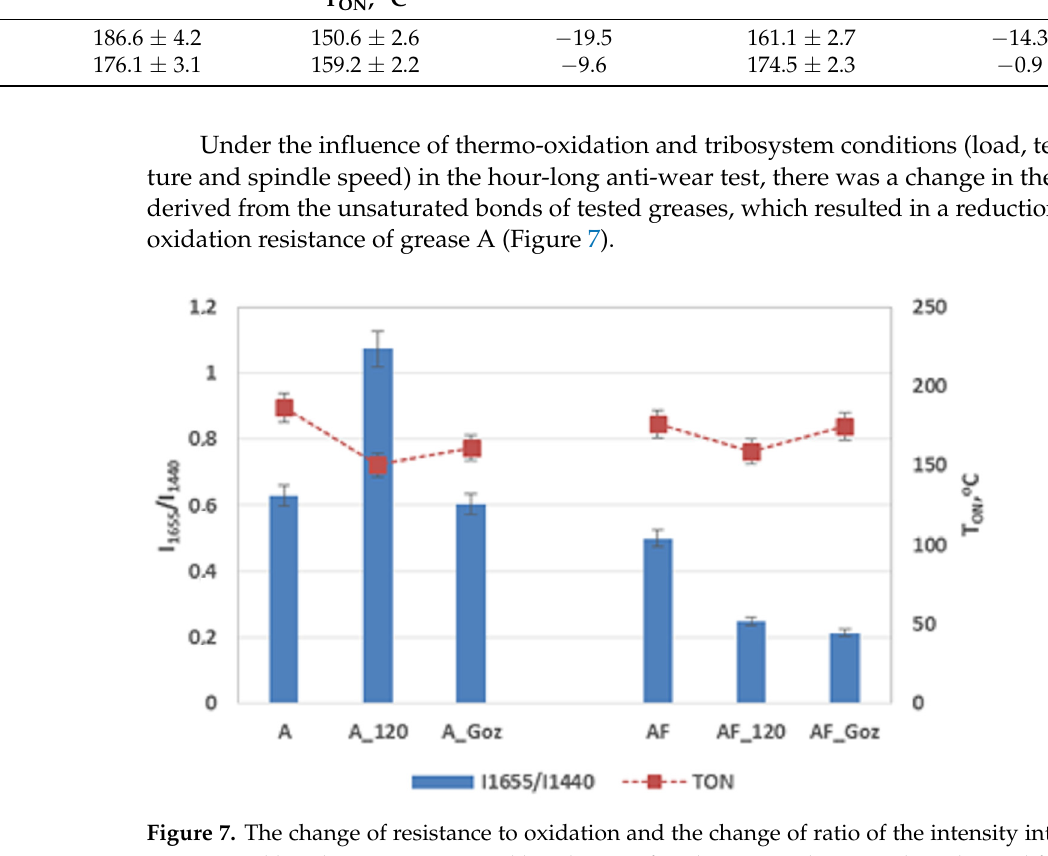
Table 3. The impact of extortions on changing resistance to the lubricant oxidation process—DSC method.